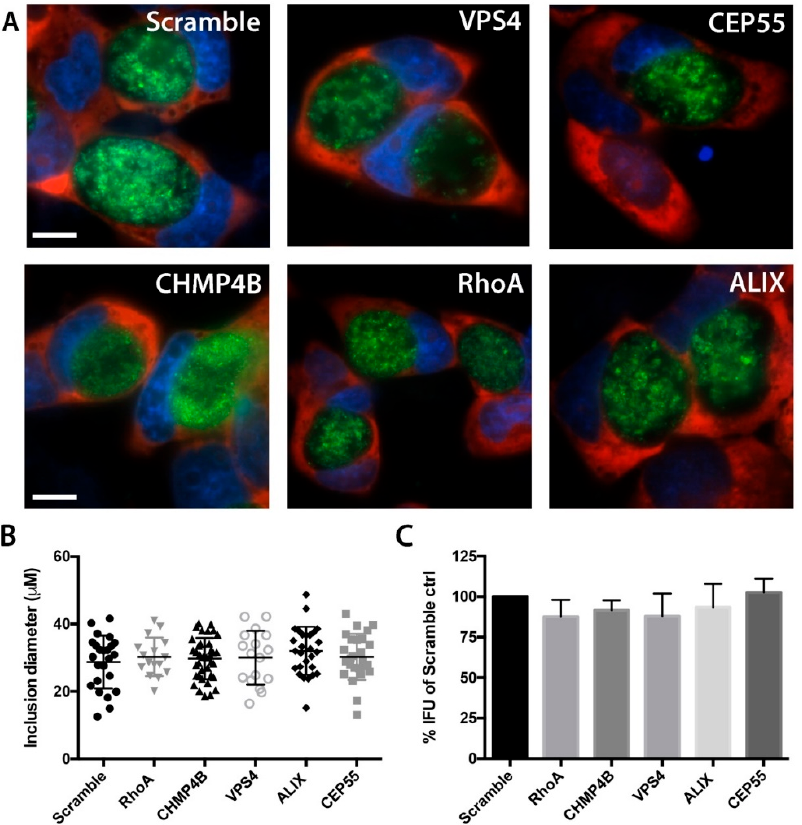
Figure 4. Primary C. trachomatis infections are not affected by abscission protein RNAi. ( A ) Morphologies of C. trachomatis inclusions at 48 hpi following siRNA treatments with a nontargeting control (Scramble), VPS4, CEP55, CHMP4B, RhoA, and ALIX. Images were acquired at 60X magnification. GFP-expressing C. trachomatis (green), mCherry-HeLa cells (red), and DAPI-labeled